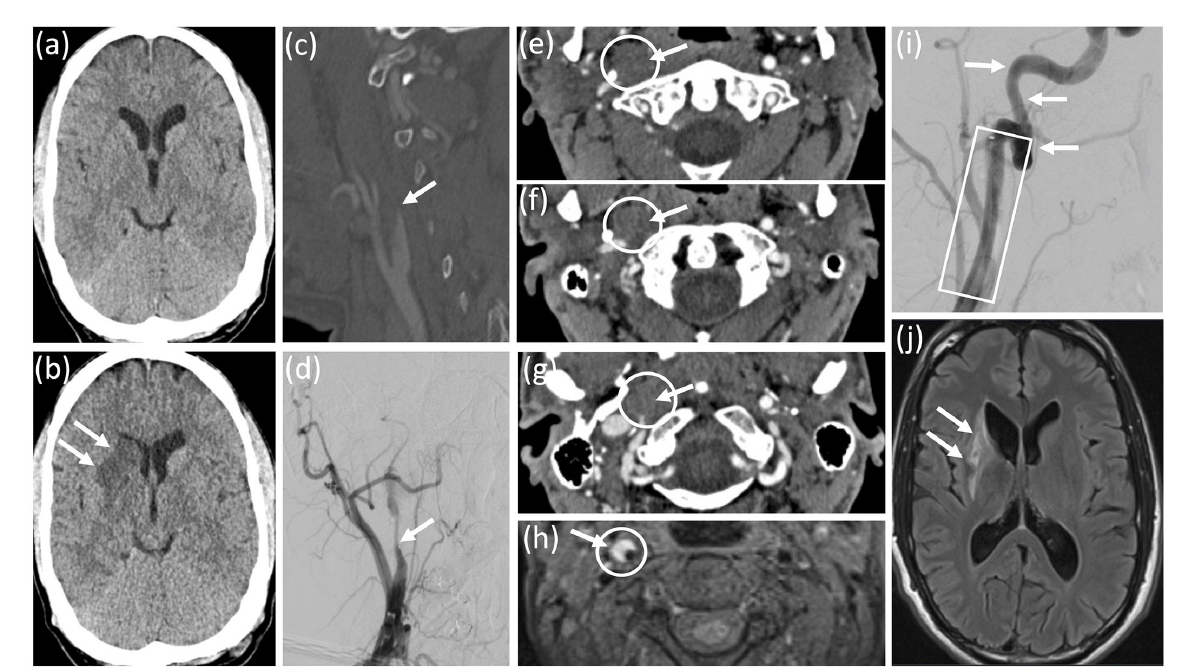
FIGURE1 Diagnostic work-up and follow-up. (a) Initial computed tomography of the brain was unremarkable. (b) Computed tomography of the brain 24h after symptom onset revealed an incomplete ischemic lesion within the territory of the right lenticulo-striatal arteries. Computed tomography angiography (c) and conventional cerebral angiography (d) revealed a filiform stenosis of the right internal carotid artery about 1.5cm from the carotid bifurcation. (e–g) transversal computed tomography scans showed an intramural haematoma of the right internal carotid artery. (h) Transversal T1-weighted magnetic resonance imaging with fat suppression confirmed mural haematoma of the right internal carotid artery. (i) Conventional angiography after intra-arterial mechanical thrombectomy and stent implantation illustrated no residual stenosis of the right internal carotid artery. (j) Fluid attenuated inversion recovery magnetic resonance imaging 10 weeks from symptom onset revealed the ischemic lesion within the territory of the right lenticulo-striatal arteries, but no additional